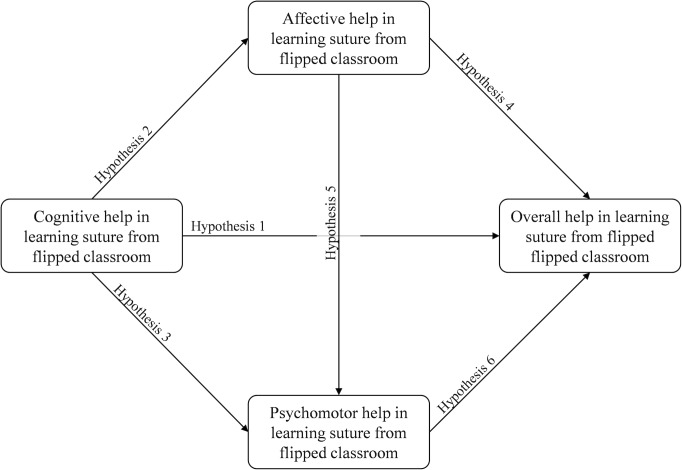
The research conceptual model depicting mediation of helps from flipped classroom.